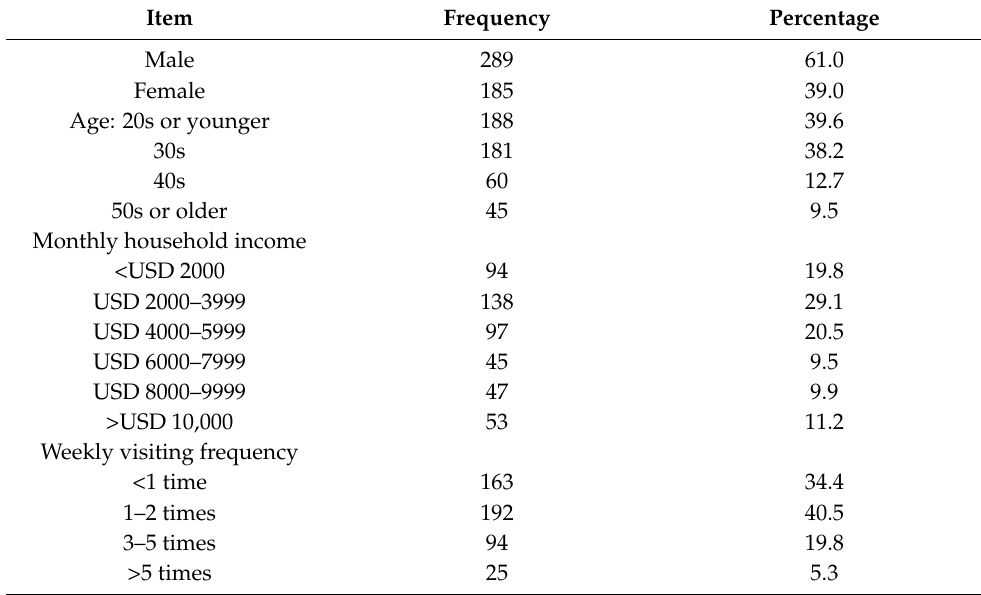
Table 2. Profile of survey participants ( n =